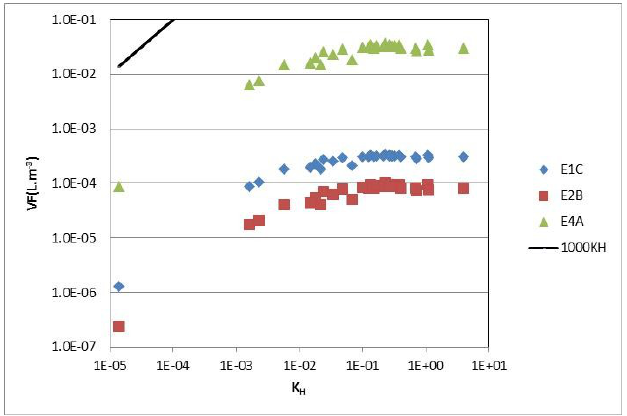
for spherical droplet H